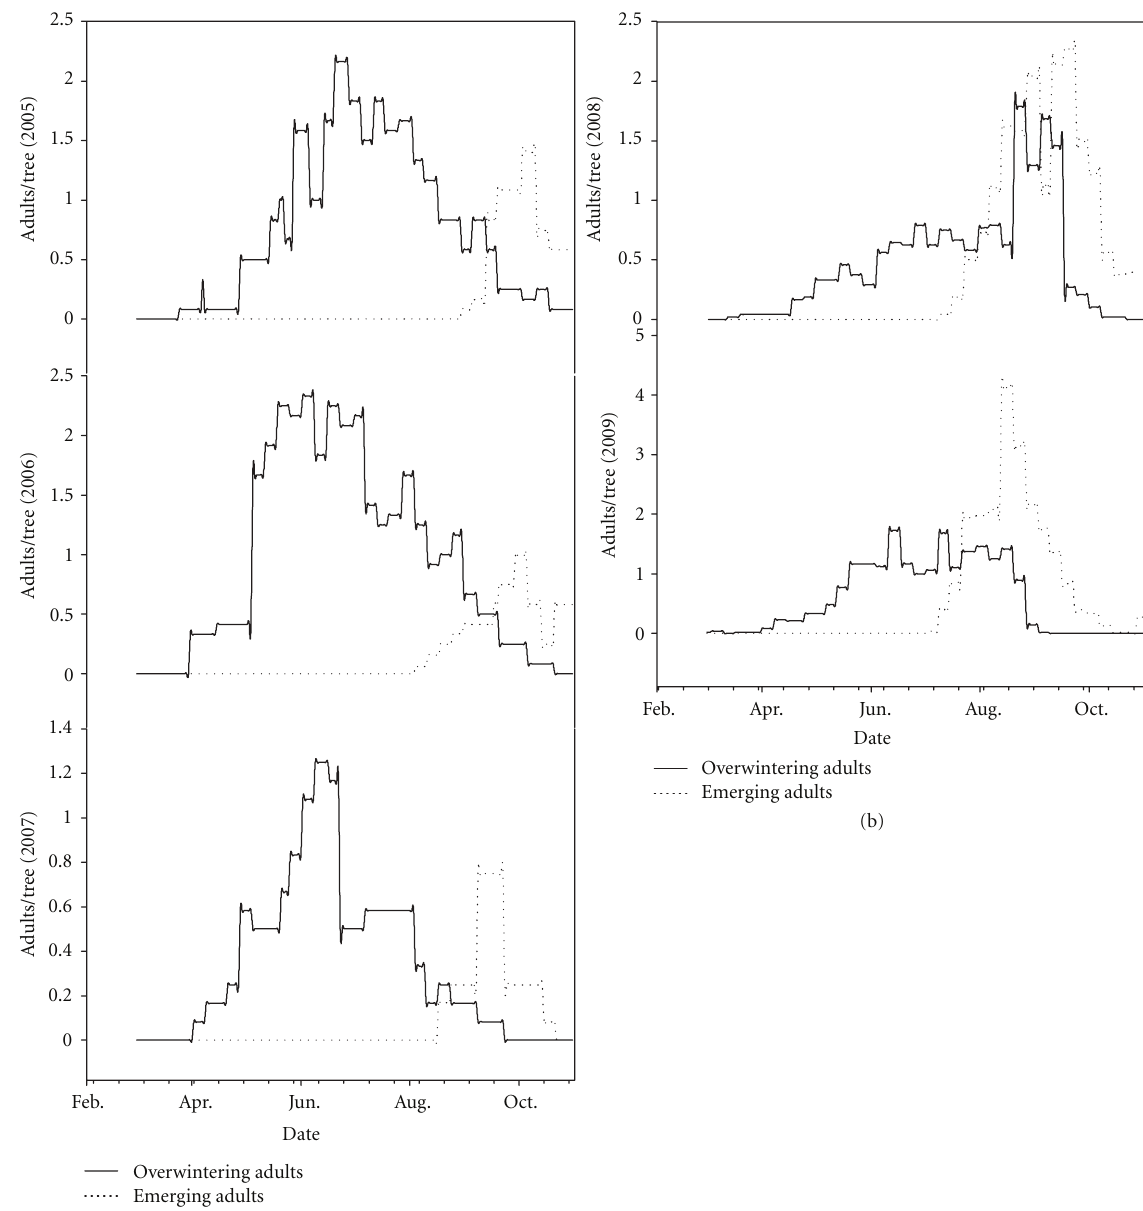
Figure 3: Adult presence of Capnodis tenebrionis in a temperate area ( a ) and in a semiarid area ( b ). The early onset and the overlapping of generations of adults are evident in the warmer